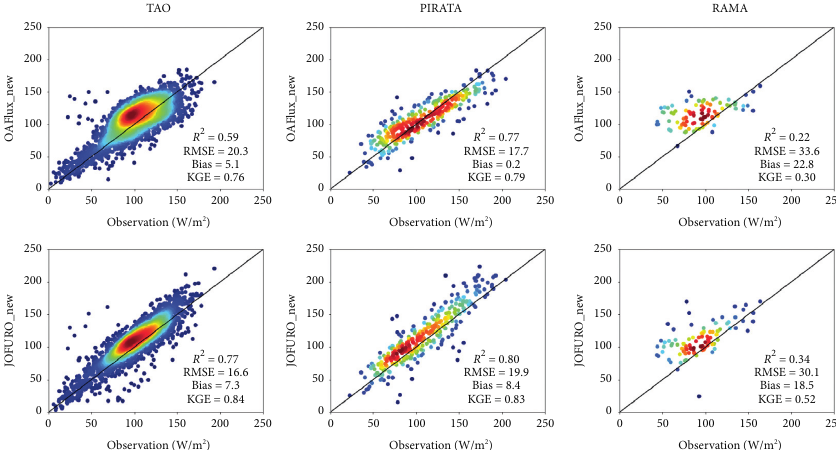
Figure 11: Comparison of new ocean LHF (units: W/m 2 ) products (OAFlux_new and JOFURO_new) against observations. “_new” represents the datasets estimated using SST4